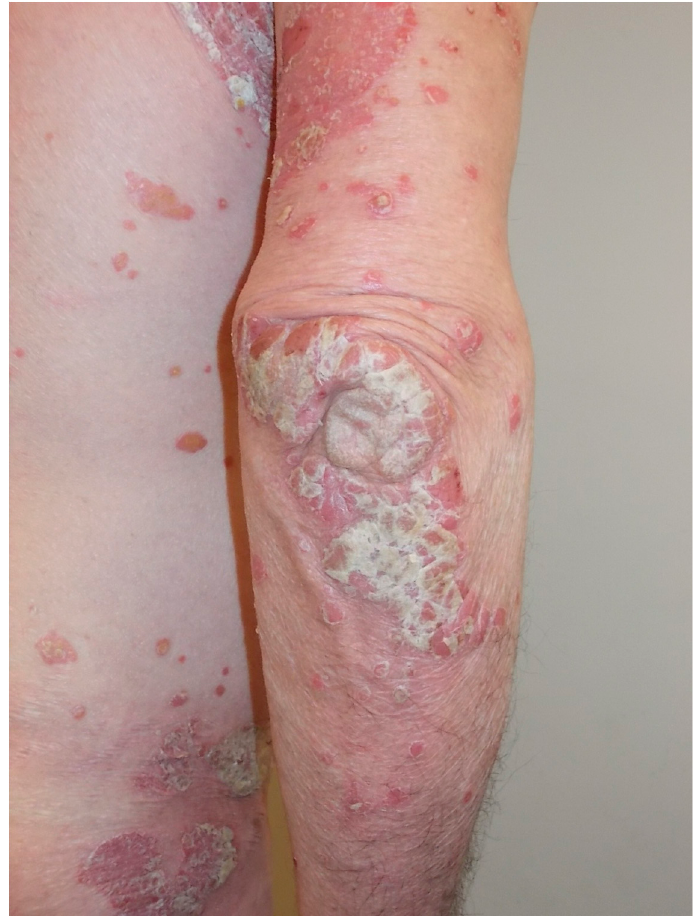
Figure 1. Psoriatic lesions on the elbows.